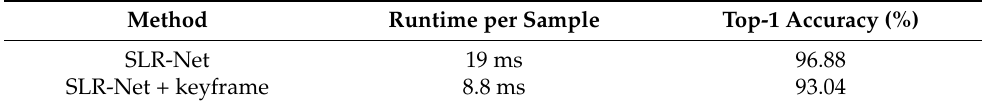
Table 10. The accuracy and runtime